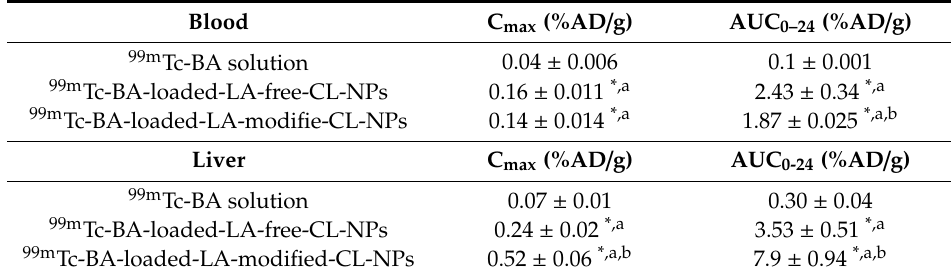
Table 6. Mean ( ± SD) pharmacokinetic parameters of BA in blood and liver tissue following oral administration of radiolabeled 99m Tc-BA to